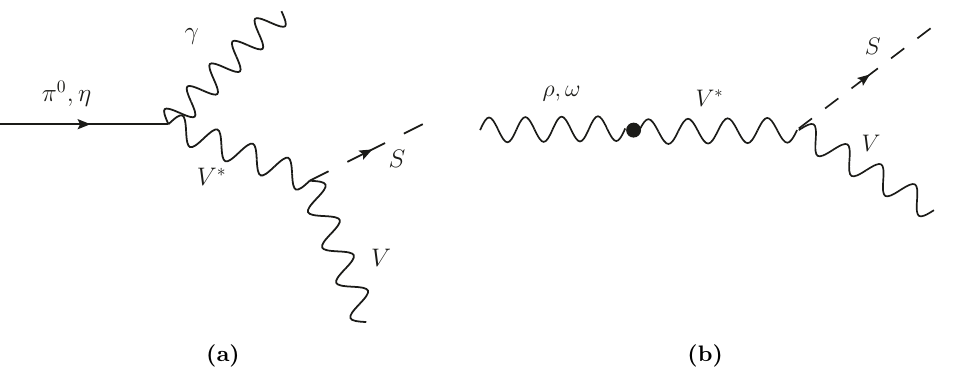
Figure 4. Dark Higgs production in scalar (a) and vector (b) meson decay through dark Hig-